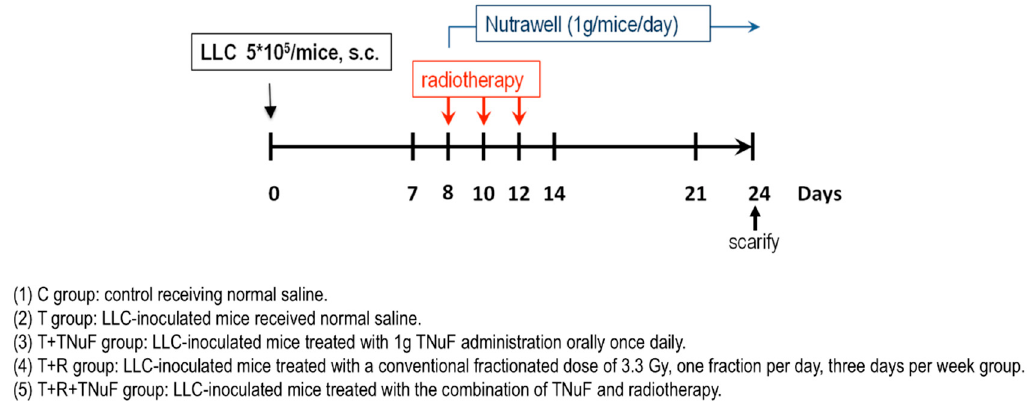
Figure 1. The treatment schedule of total nutrition formula (TNuF) and irradiation in tumor-bearing mice. To minimize experimental error, 5 × 10 5 LLC cells in 100 µ L were unilaterally inoculated into the right posterior flank region of each BALB / c nude mouse. At the 7th day post tumor-cell inoculation, mice were given 1 g / mice / day TNuF in 200 µ L normal saline via oral gavage until sacrifice. Fourteen days later (on the 21th day), the mice were anesthetized and sacrificed, where the organs were